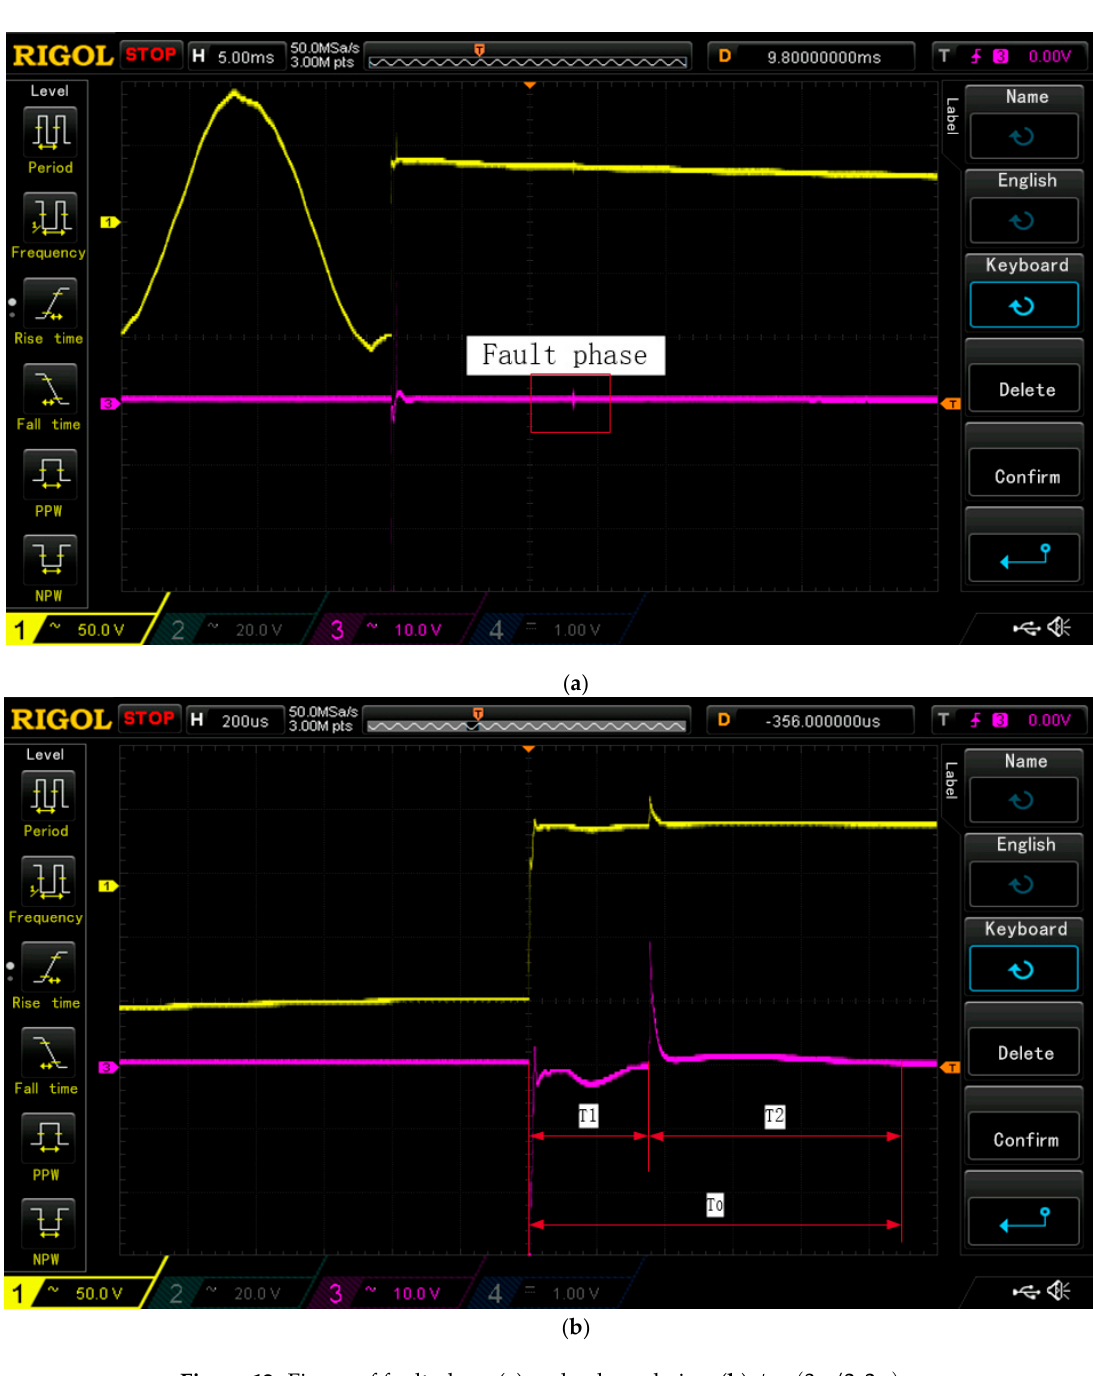
Figure 12. Figure of fault phase ( a ) and enlarged view ( b ) )2,2/3(